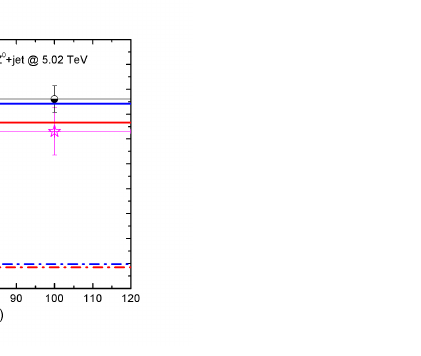
Figure 9. Distributions of averaged number of jet per Z boson R jZ in p + p and central Pb + Pb collisions at the LHC.